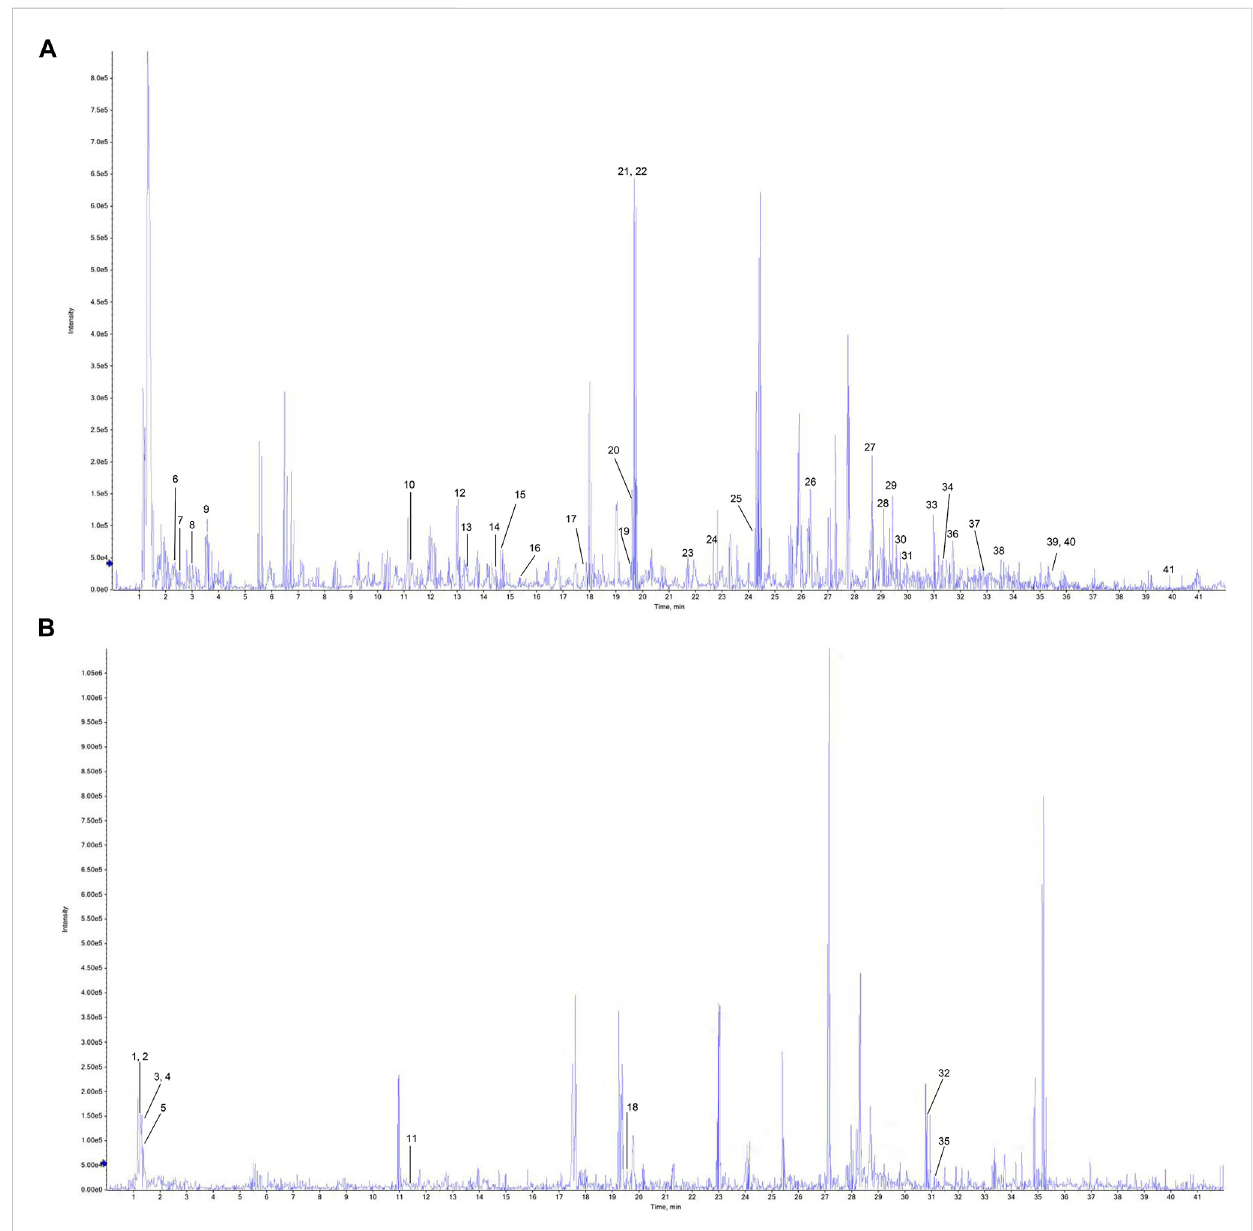
FIGURE 2 Total ion fl ow chromatogram of the P-A drug pair. (A) Negative ion diagram. (B) Positive ion